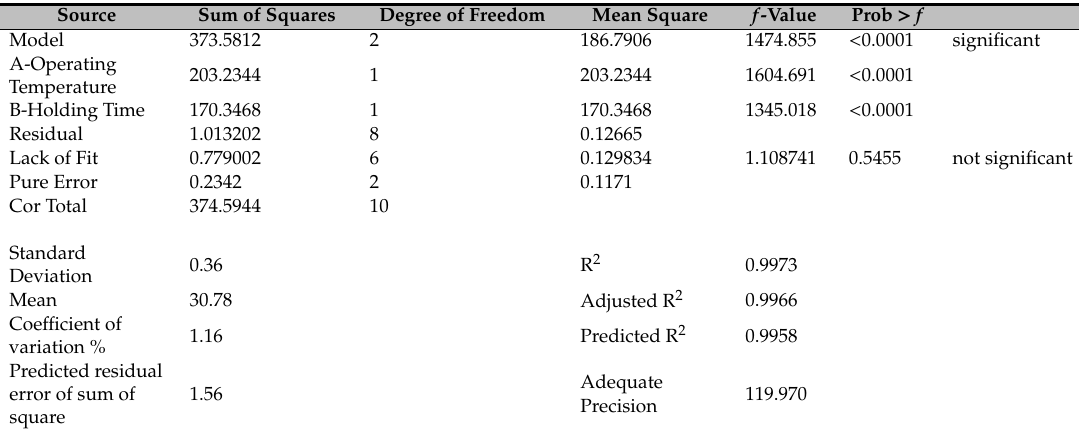
Table 11. ANOVA table for global warming potential,